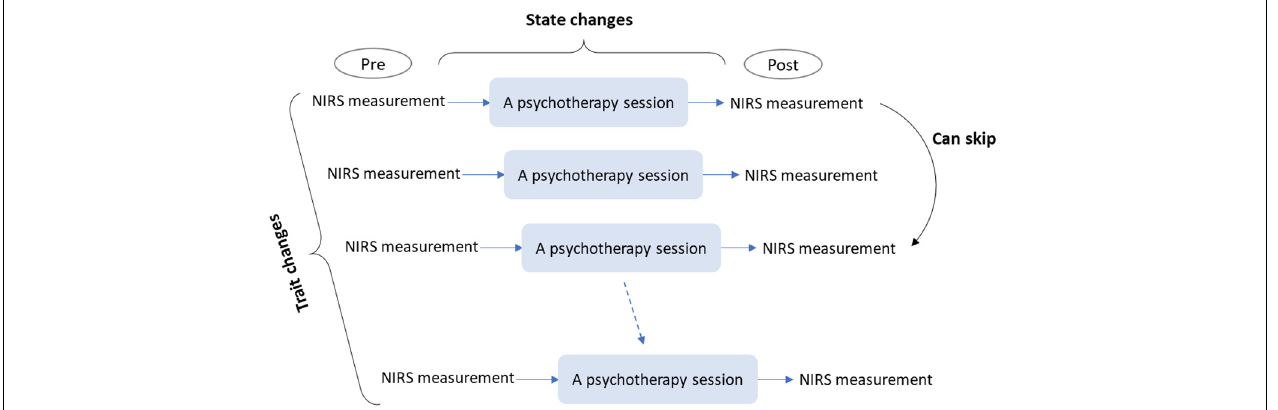
FIGURE 2 | A conceptual schema for single- and multi-session evaluations of psychotherapeutic effects using NIRS. Single-session evaluation can be conducted by immediate pre- and post-intervention measurements of rCBF changes. This evaluation allows for the measurement of state changes in brain activity induced by a single session. Multi-session evaluation can be conducted by repetitive single-session evaluations, which allows for the examination of trait changes in brain activity induced by a psychotherapy program. NIRS, near-infrared spectroscopy; rCBF, regional cerebral blood